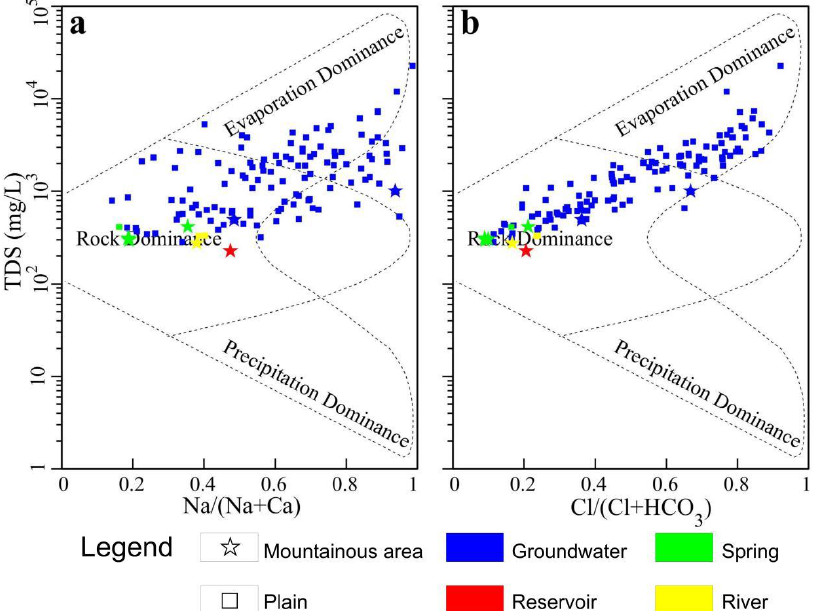
Figure 4. Analysis of chemical origin of groundwater. ( a ) Na/(Na+Ca), ( b ) Cl/(Cl+HCO 3 ). Na + and K + in groundwater mainly come from atmospheric precipitation and rock salt dissolution. Without the influence of human activities, rock salt dissolution is the main source of Na + and Cl − in groundwater, and the ratio of their concentrations (mil- liequivalents per liter, mEq/L) is generally around 1. As shown in Figure 5a, the ratio of the concentration of Na + to that of Cl − in the groundwater of the Chahannur Basin is about 1, indicating that Na + in the groundwater of the Chahannur Basin mainly comes from at- mospheric precipitation and rock salt dissolution.